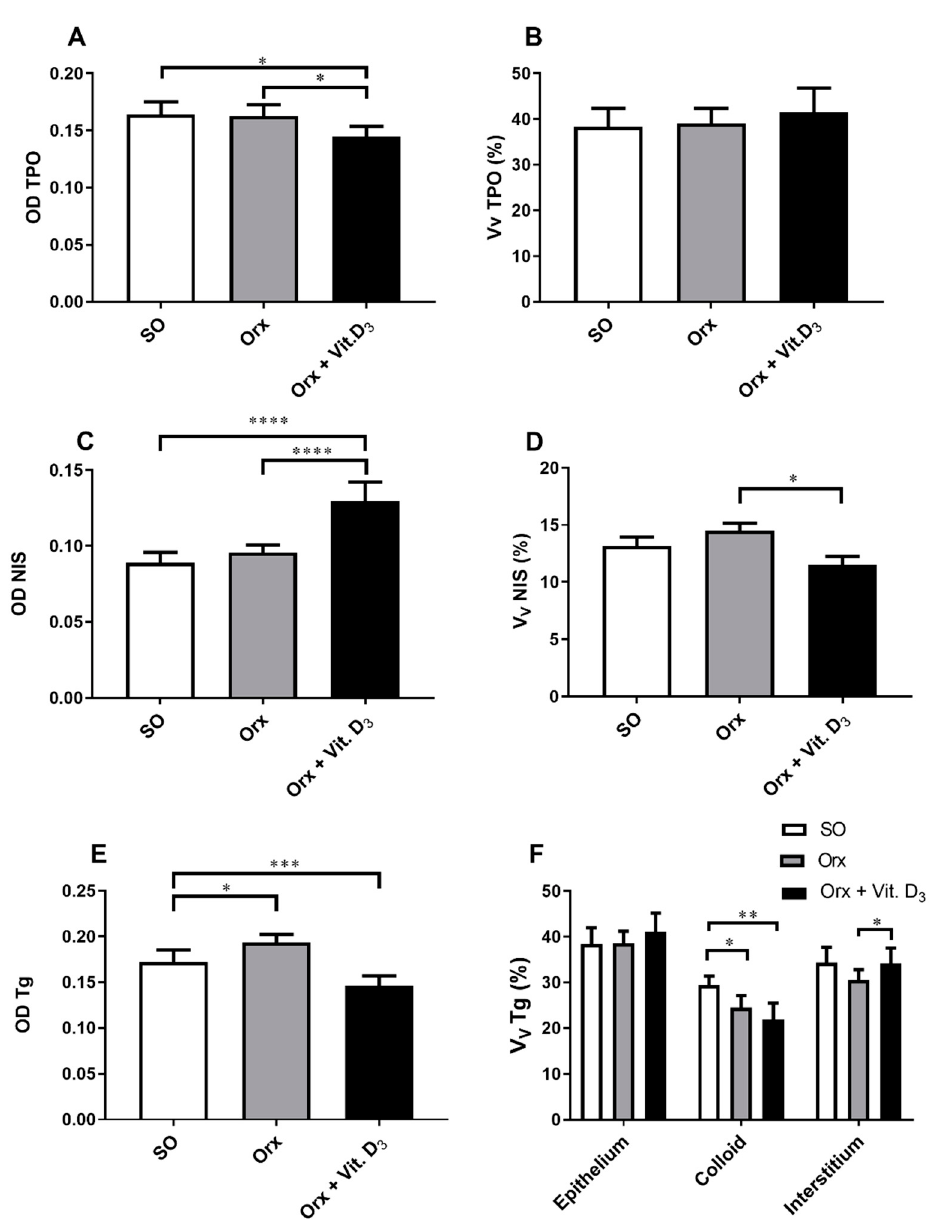
Figure 4. Optical density (OD) of TPO and and the relative volume density of TPO immunopositivity (V V TPO; %) ( A , B ), OD of NIS immunopositivity ( C ) and the relative volume density of NIS membrane immunopositivity (V V membrane NIS; %; ( D ), OD of Tg ( E ) and the relative volume density of Tg-immunopositive epithelium and colloid, as well as Tg-negative interstitium (Vv; %; ( F )) in the thyroid of sham-operated (SO), orchidectomized (Orx), and orchidectomized cholecalciferol-treated (Orx + Vit. D3) rats. All values are means ± SD ( n = 6); * p < 0.05; ** p < 0.01; *** p < 0.001; **** p < 0.0001.